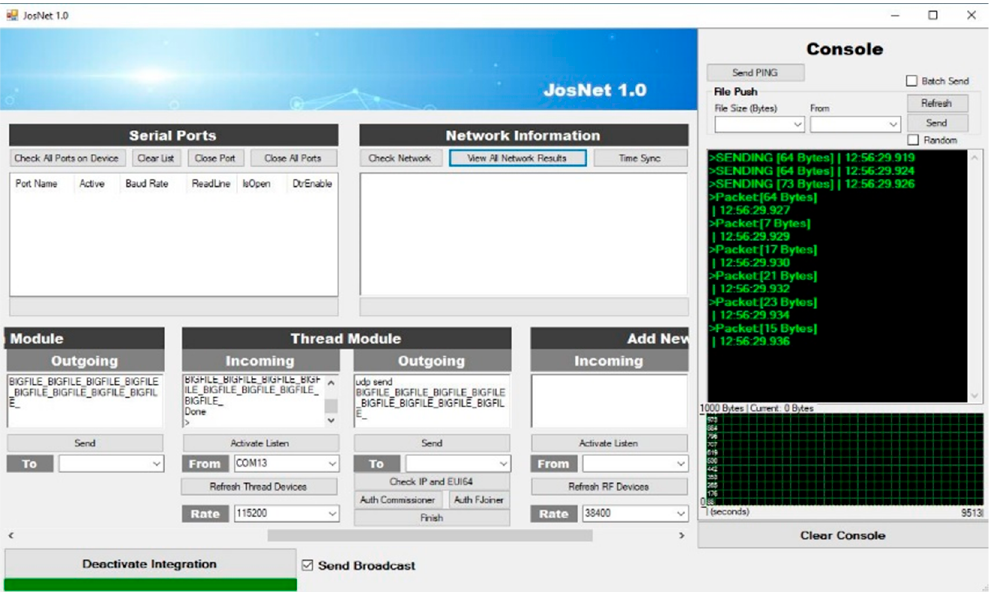
Figure 6. JosNet Interface (with graphs and console display) PC2 (destination), which receives data packets from PC1 (source).